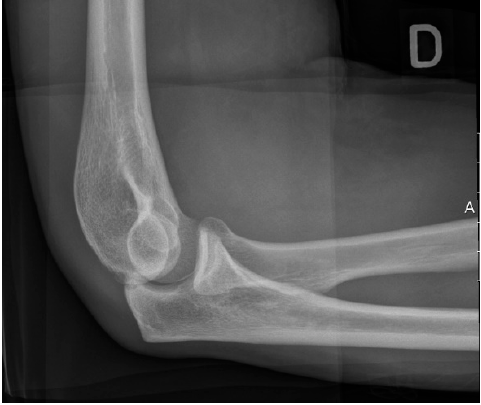
Figure 2. Lateral radiograph of the elbow in a healthy patient.